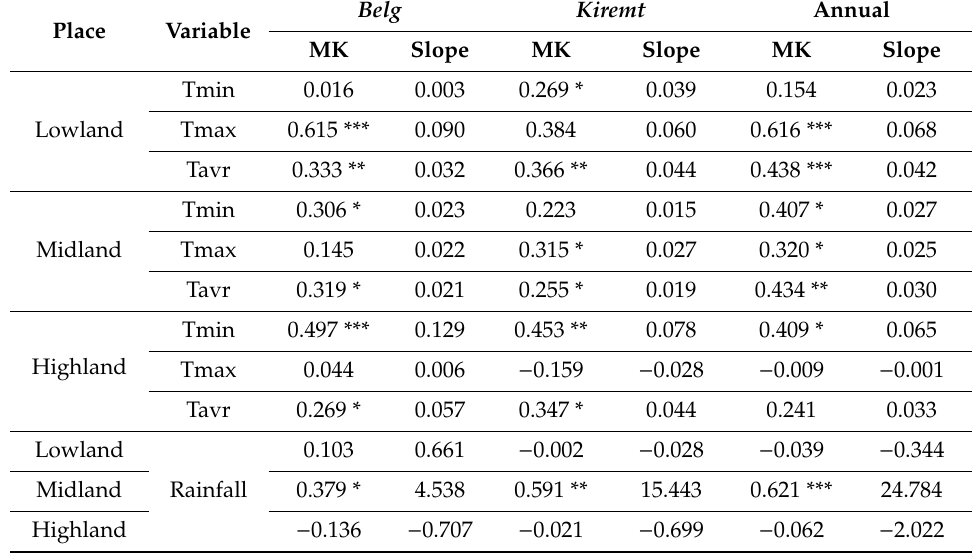
Table 1. Agro-ecological di ff erences in seasonal and annual trends of temperature and rainfall (1988–2017). Belg Place Variable